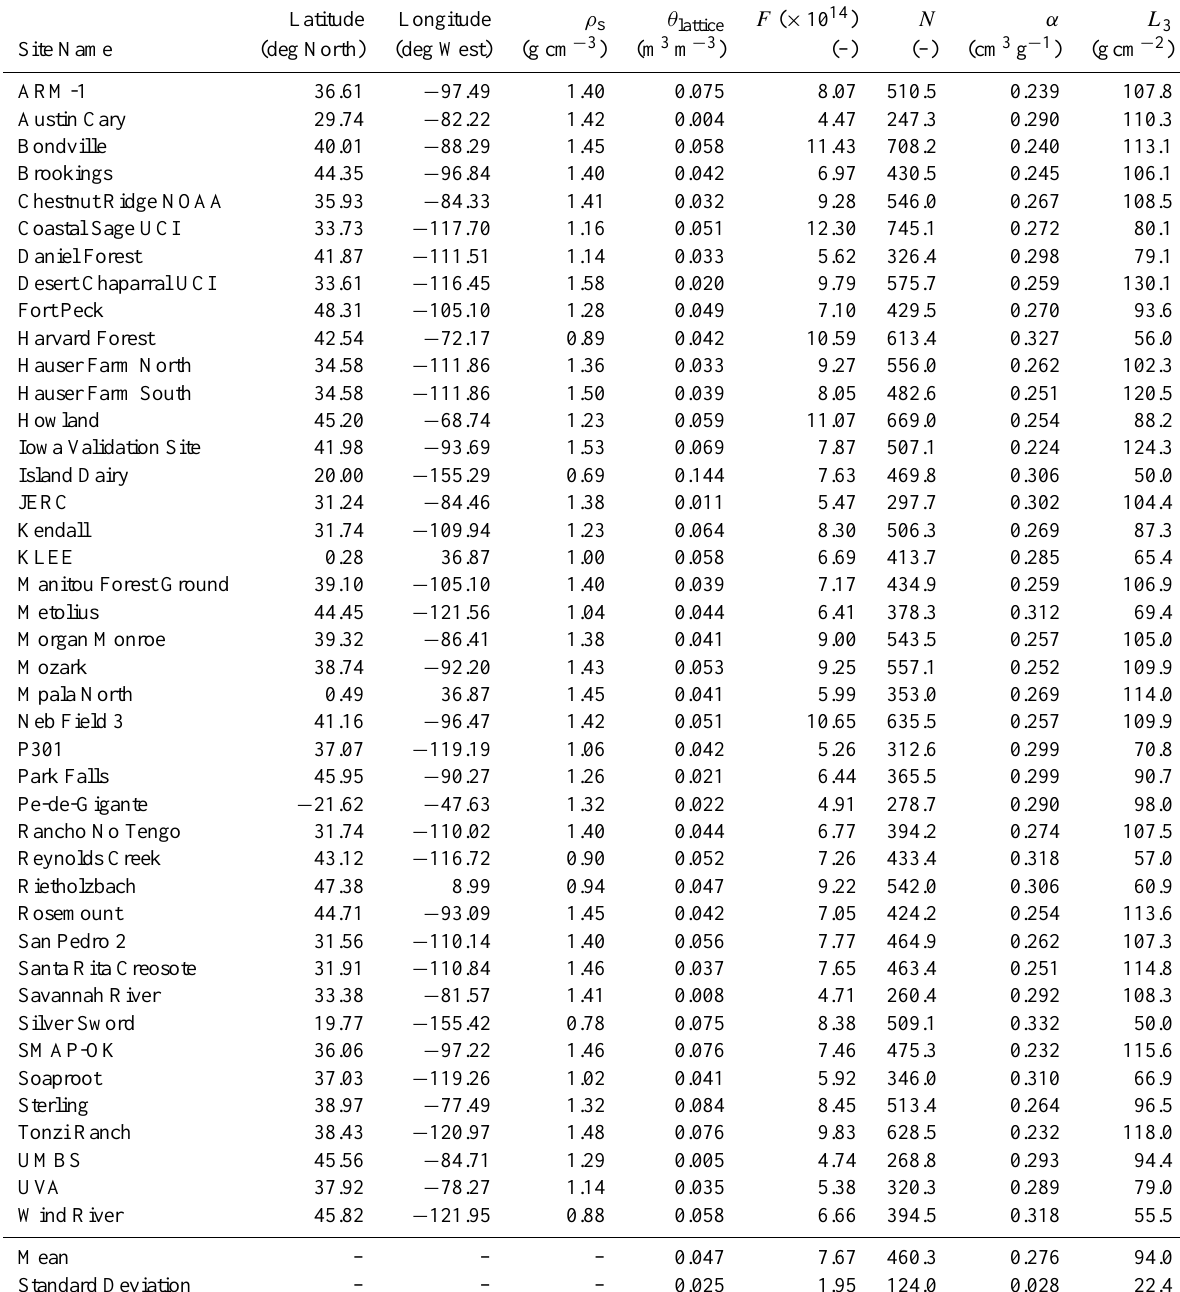
Table 1. Site-specific values of latitude and longitude; ρ s (gcm − 3 ) , θ lattice (m 3 m − 3 ) and F ; and the parameters N,α (cm 3 g − 1 ) and L 3 (gcm − 2 ) obtained by calibrating the COSMIC model against MCNPX at the 42 COSMOS sites shown in Fig. 3 with L 1 = 162 . 0gcm − 2